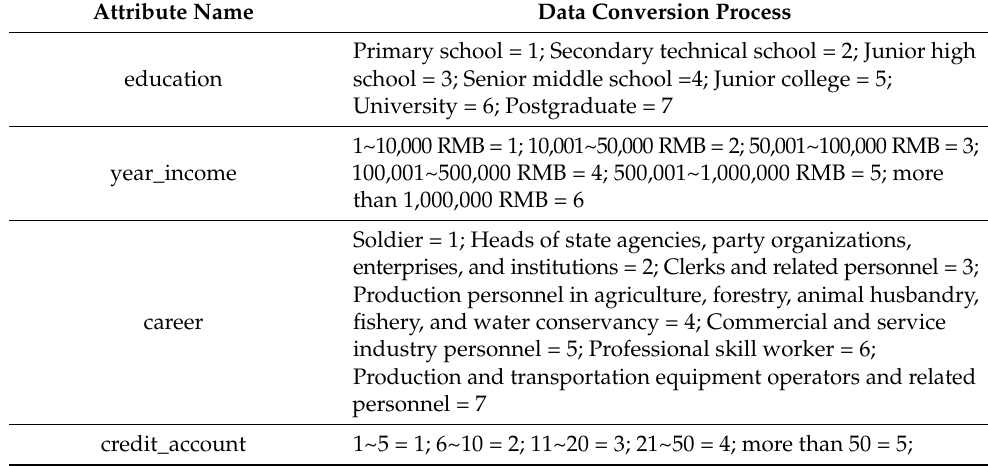
Table 5. Representative the credit variable data conversion process record.